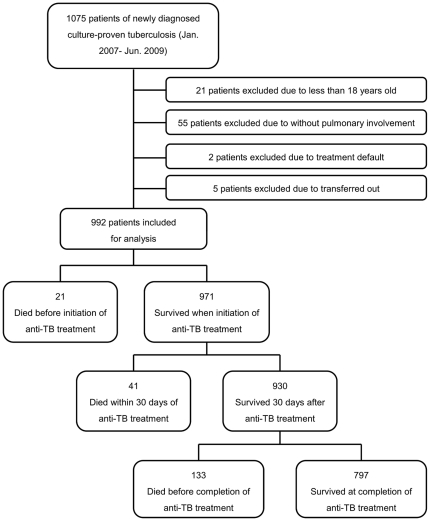
Study profile demonstrating the number of cases and reasons for exclusion.